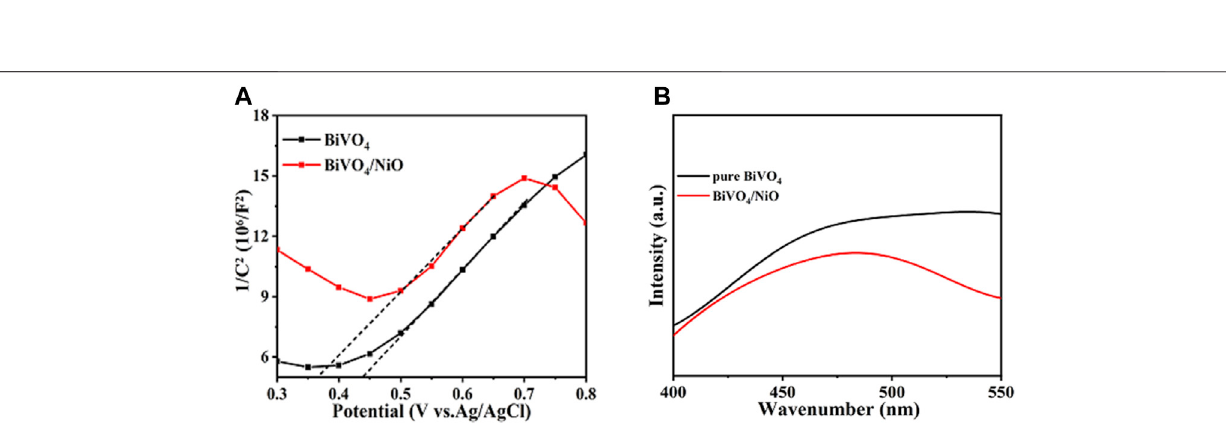
FIGURE 6 | M-S diagram (A) and PL spectra of electrodes (B) .